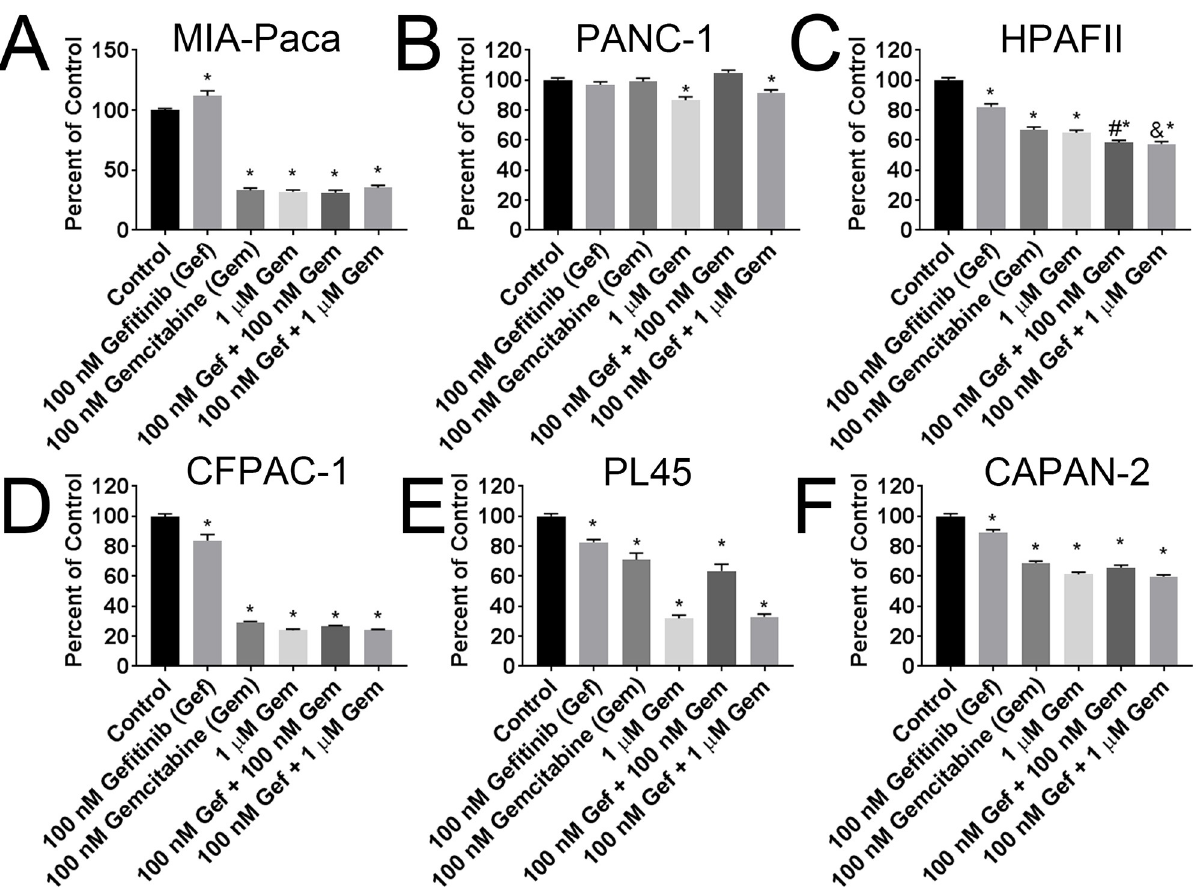
Fig 4. Combination treatment of gefitinib and gemcitabine in select cell lines. MTT of 3-day treatment of the 100 nM gefitinib alone or in combination with 100 nM or 1 μ M gemcitabine in (A) MIA-PACA, (B) PANC-1, (C) CFPAC-1, and (D) HPAF-II. MTT of 6 day treatment of the 100 nM gefitinib alone or in combination with 100 nM or 1 μ M gemcitabine in (E) PL45, and (F) CAPAN-2 cells. � denotes p < 0.05 when compared to control by one-way ANOVA and Tukey post-test. # denotes p < 0.05 when compared to 100 nM gefitinib alone and 100 nM gemcitabine alone by one- way ANOVA, Tukey post-test, and Chou Talalay CI value equal to or less than 1. & denotes p < 0.05 when compared to 100 nM gefitinib alone and 1 μ M gemcitabine alone by one-way ANOVA, Tukey post-test, and Chou Talalay CI value equal to or less than 1. Assays were completed in triplicate.